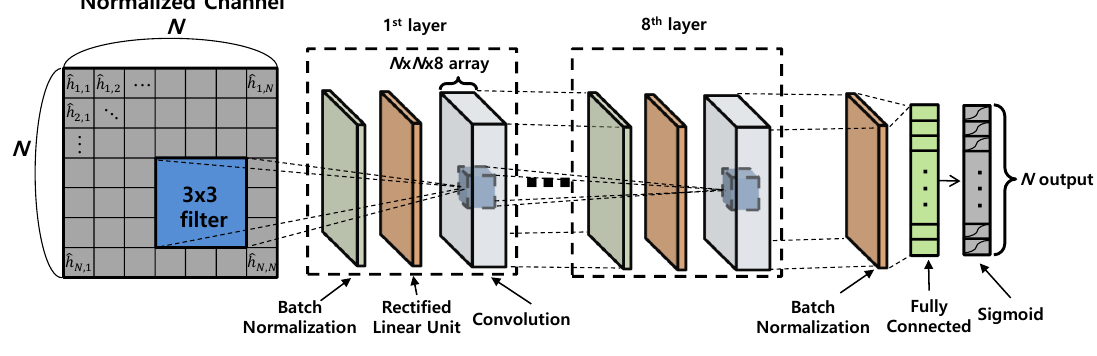
Figure 2. Proposed CNN